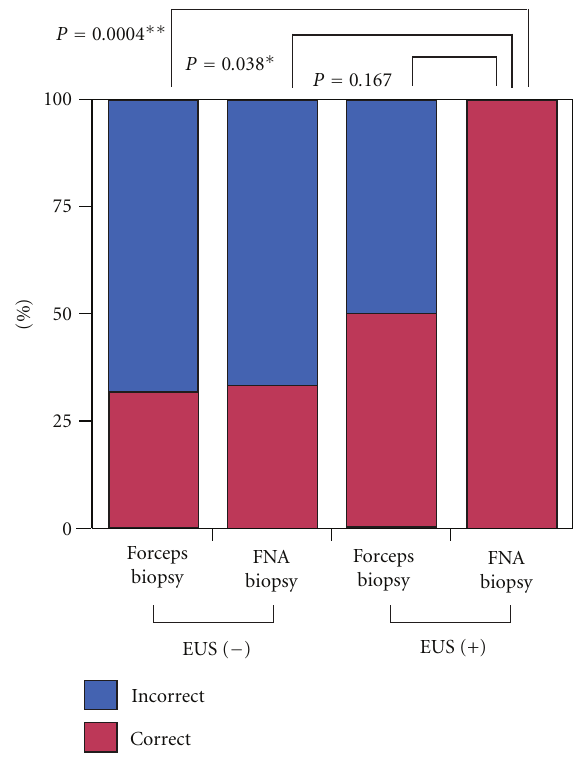
Figure 2: Consistency of pathological diagnosis between biopsy and surgical specimens. All 34 biopsies were categorized by presence of EUS and FNAB as EUS-guided FNA biopsy (EUS+/FNAB, 10 biopsies), forceps biopsy with EUS (EUS+/forceps, 2 biopsies), FNA biopsy without EUS (EUS − /FNAB, 3 biopsies), and forceps biopsy without EUS (EUS − /forceps, 19 biopsies). The EUS+/FNAB group had significantly better diagnostic accuracy than the EUS − /FNAB and EUS − /forceps groups ( P = 0 . 038 and P = 0 . 0004). Although this di ff erence was not statistically significant, the EUS+/FNAB group had better accuracy than the EUS+/forceps